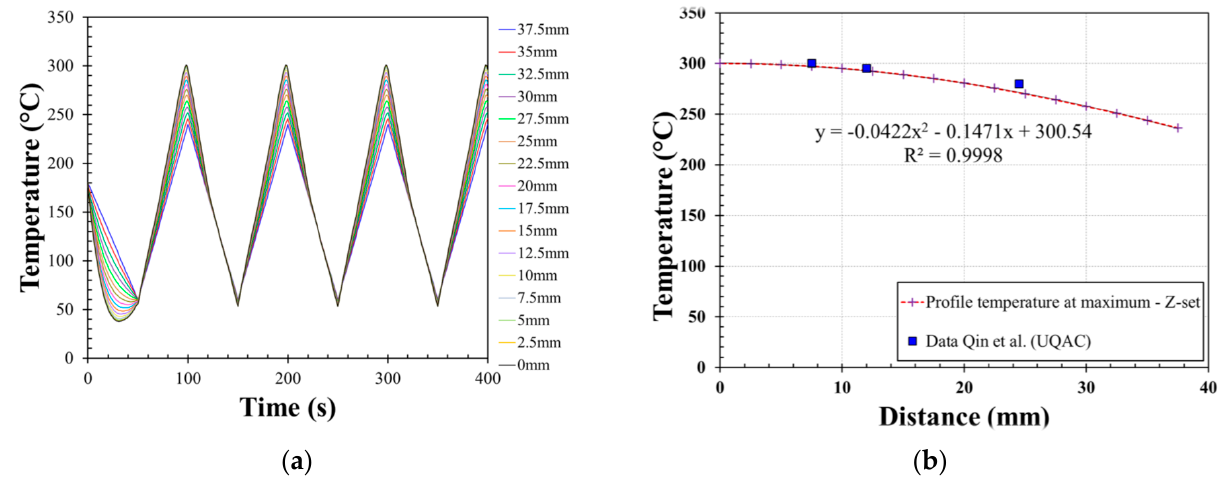
Figure 6. ( a ) Evolution of the surface temperature along the longitudinal axis of the specimen as modeled by Z-set, ( b ) profile temperature at the top of a cycle and comparison with experimental points on Gleeble ® .